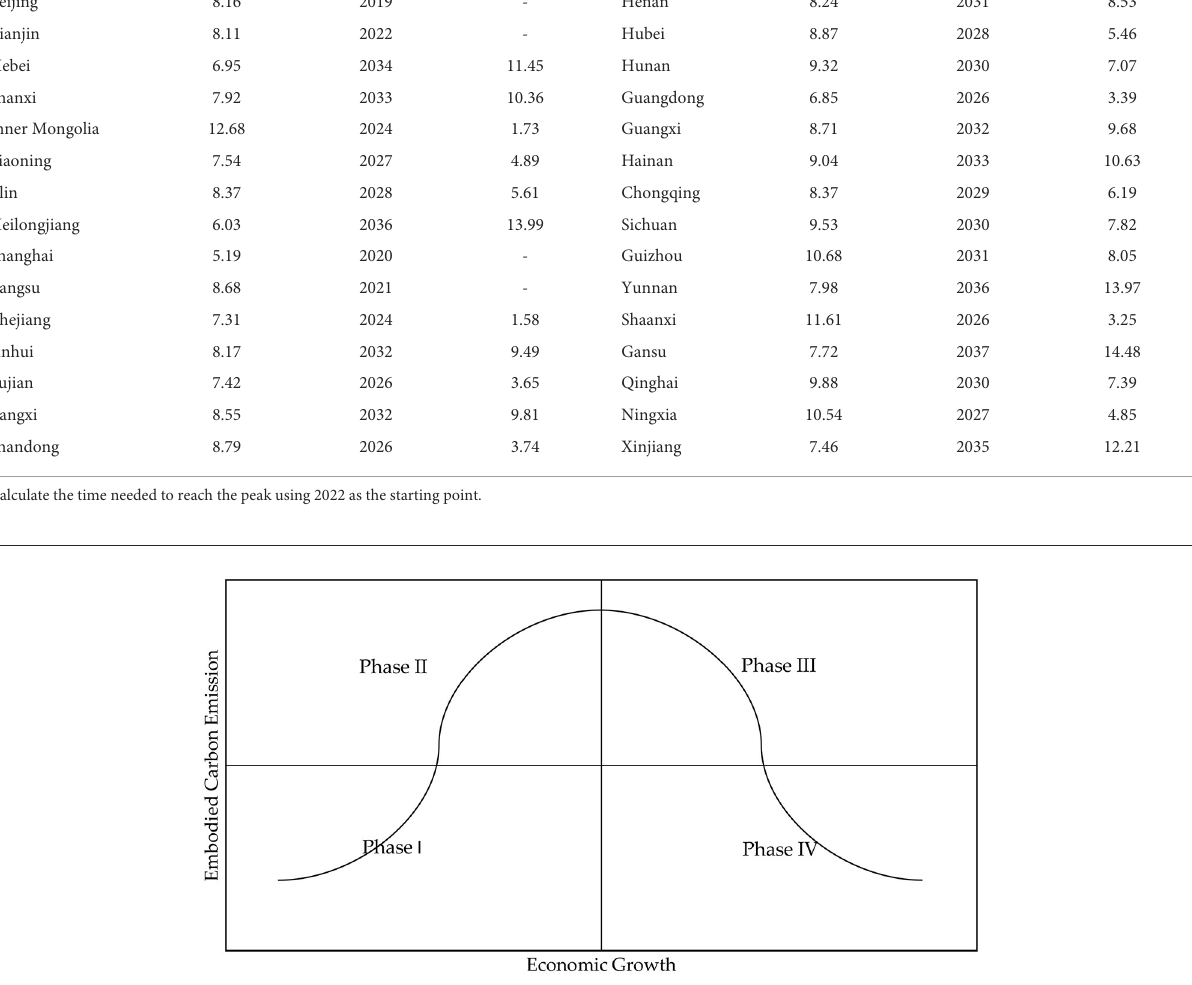
Each stage’s features are mentioned